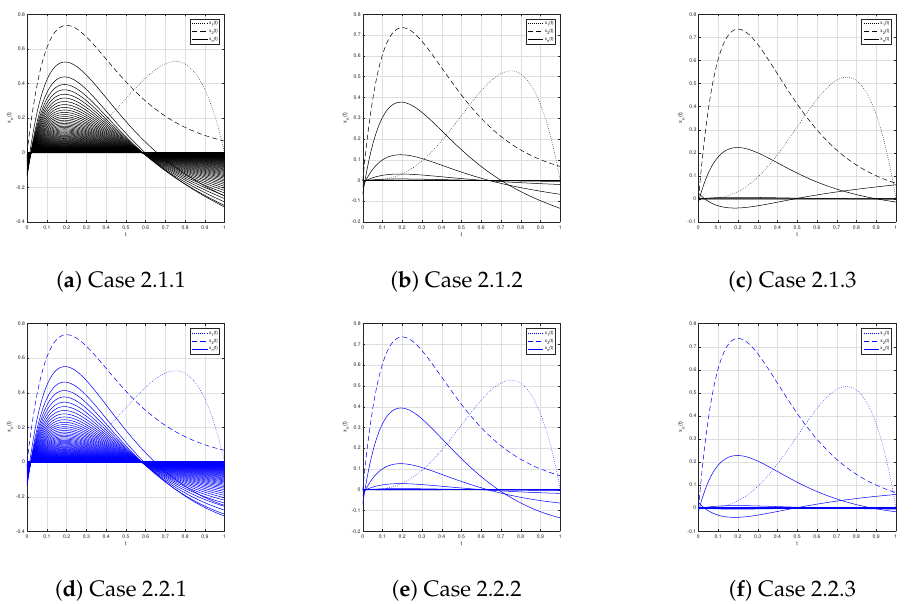
Figure 3. Convergence behavior of the sequence { x n ( t ) } with and without the extrapolation factor ( θ n ) for Case 2.